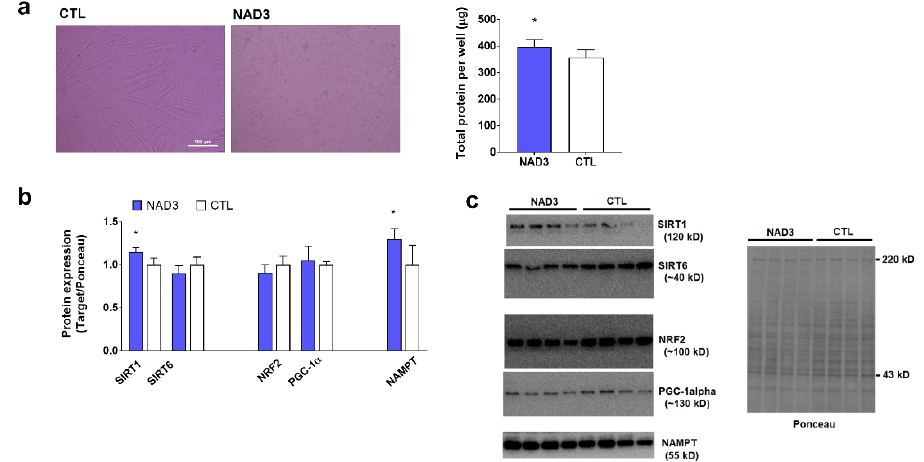
Figure 3. Effects of NAD3 treatments on select protein targets. Legend: these data illustrate 24 h NAD3 treatments that do not affect cellular morphology, while also increasing protein levels per well (a surrogate of cellular health) (panel a ). Twenty-four hour NAD3 treatments also increased SIRT1 and NAMPT protein levels, while not affecting other protein targets (panel b ). Panel c also illustrates representative Western blots of each assayed target. All data are presented as the means ± standard deviation values ( n = 5–6 treatment wells per condition), and significance was set at p < 0.05. Symbols: *, indicates more highly expressed in NAD3-treated versus control (CTL)-treated cells.